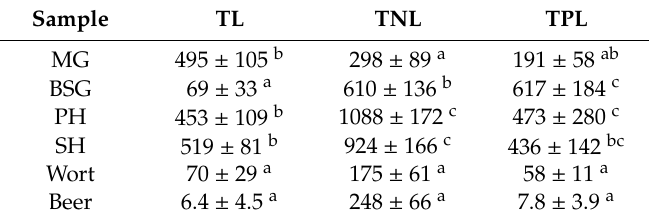
Table 3. The in vitro biological activities of the total lipids (TL), total neutral lipids (TNL), and total polar lipids (TPL) of the beer and brewing by-products against platelet-activating factor (PAF)-induced human platelet aggregation, expressed as an IC 50 in micrograms ( µ g) of the sample extract. The hPRP concentration was approximately 500,000 platelets µ L − 1 . The final concentration of PAF in the cuvette was 2.6 × 10 − 8 M. All experimental analyses were carried out in triplicate (mean ± SD, n = 3). Sample TL TNL TPL MG 495 ± 105 b 298 ± 89 a